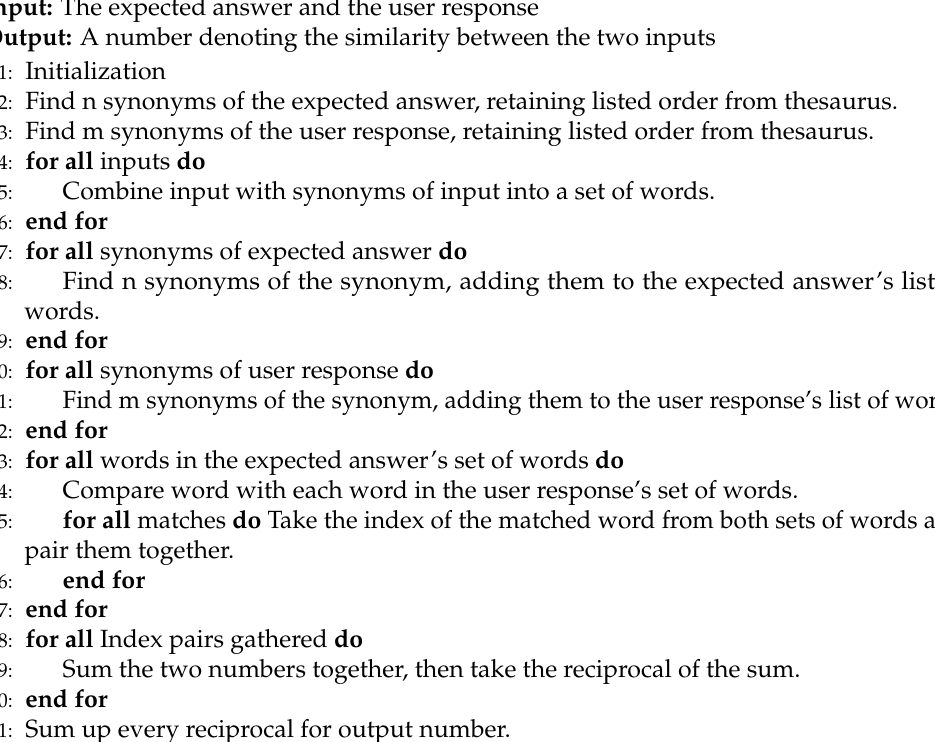
Figure 9. Analyzing the user’s response. Algorithm 1 Word-Matching Similarity Score